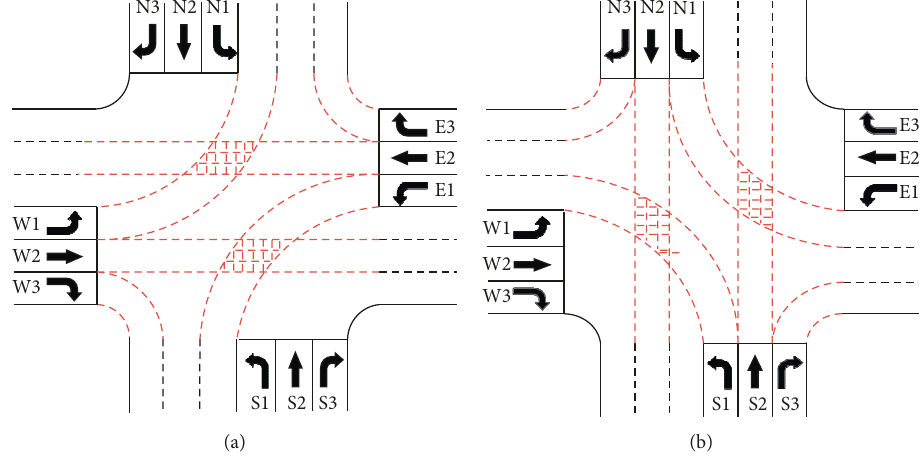
Figure 3: Vehicle trajectories at a signalized intersection. (a) Phase 1: vehicle trajectories of east-west approach. (b) Phase 2: vehicle trajectories of north-south approach.